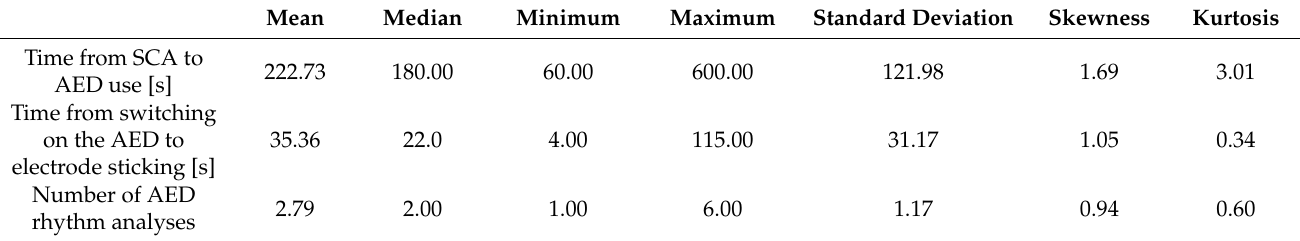
Table 4. Basic descriptive statistics on the number of defibrillations and the number of rhythm analysis (n =